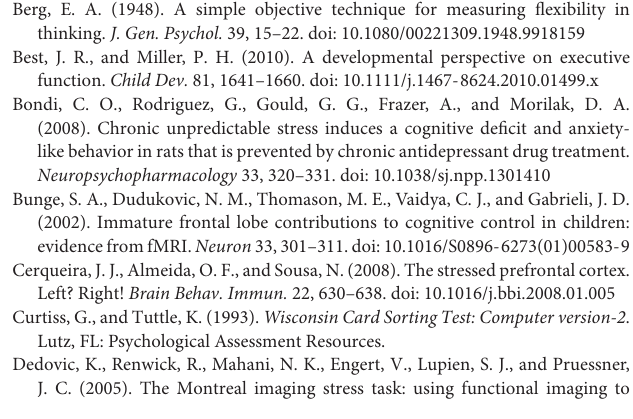
FIGURE S1 | OxyHb levels in the cortical areas for males. Functional changes represented by red curves vs. OxyHb levels in the scalp/skull areas (or systemic changes) identified by blue curves. Values represented are averaged across participants in the Stress group (left column) and Control group (right column). The X -axis presents the duration of measurement (i.e. time). The Y -axis presents the measured levels of OxyHb. 0 in the Y -axis represents the start of measurement of OxyHb levels; all changes are assessed relative to this quantity of OxyHb. Top row represents these changes in the Left-PFC region (channels 1–5). Second row represents changes in the Mid-Left-PFC (channels 6–10). Third row represents changes in the Mid-Right-PFC (channels 11–15). Last row represents changes in the Right-PFC (channels 16–20). FIGURE S2 | OxyHb levels in the cortical areas for females. Functional changes represented by red curves vs. OxyHb levels in the scalp/skull areas (or systemic changes) identified by blue curves. Values represented are averaged across participants in the Stress group (left column) and Control group (right column). The X -axis presents the duration of measurement (i.e. time). The Y -axis presents the measured levels of OxyHb. 0 in the Y -axis represents the start of measurement of OxyHb levels; all changes are assessed relative to this quantity of OxyHb. Top row represents these changes in the Left-PFC region (channels 1–5). Second row represents changes in the Mid-Left-PFC (channels 6–10). Third row represents changes in the Mid-Right-PFC (channels 11–15). Last row represents changes in the Right-PFC (channels